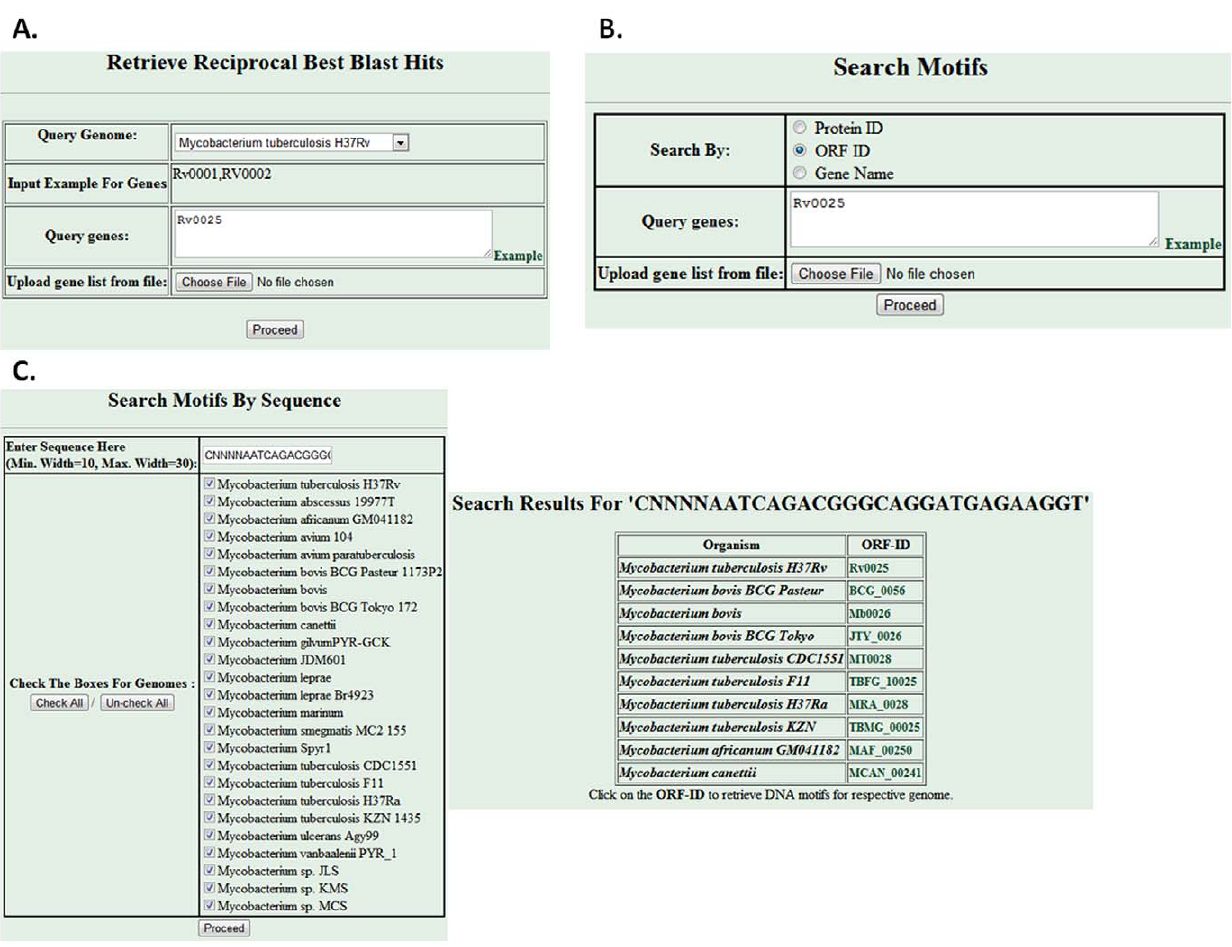
Figure 4. A searchable mode to retrieve RBBHS and DNA motifs. A. Interface to retrieve the RBBHs; B. Interface to retrieve the regulatory DNA motifs; C. Interface to retrieve the similar DNA motifs to the desired DNA sequence.